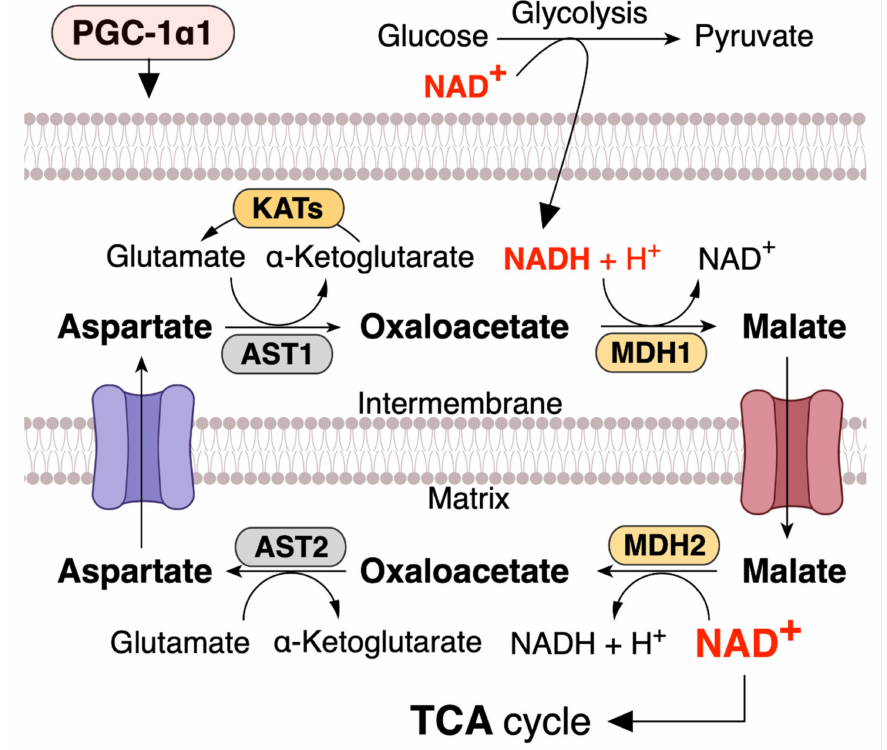
Figure 2. PGC-1 α 1 regulates malate and aspartate system (MAS) and increases mitochondrial NAD + levels in skeletal muscle. NADH produced during glycolysis enters the mitochondrial matrix via the MAS. MDH, malate dehydrogenase; AST, aspartate aminotransferase; KATs, kynurenine aminotransferases. This concept was referenced from the study by Agudelo et al. (2019)